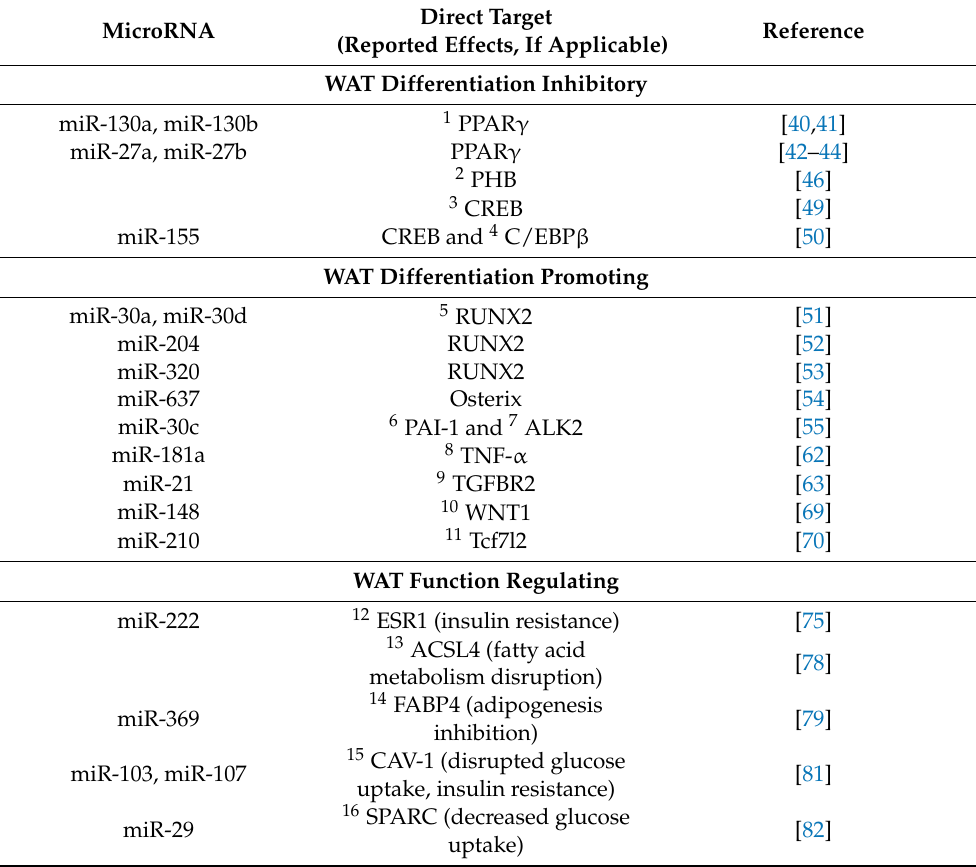
Table 1. Examples of miRNAs regulating terminal differentiation and function of WAT. Direct MicroRNA